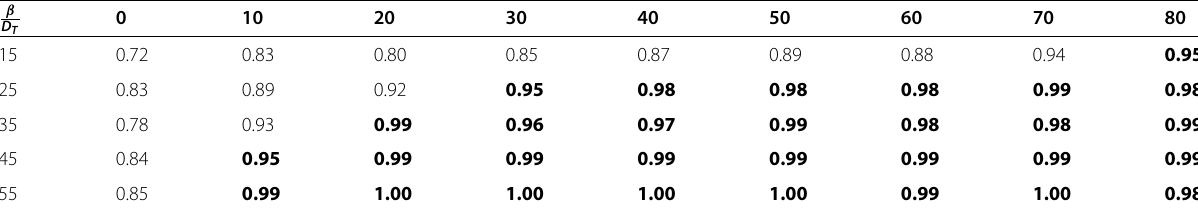
Table 1 The detection metric, F-measure, obtained by SRP-NMF on SiSEC1 data for β and D T varying from 0 to 80 and 15 to 55 respectively β D